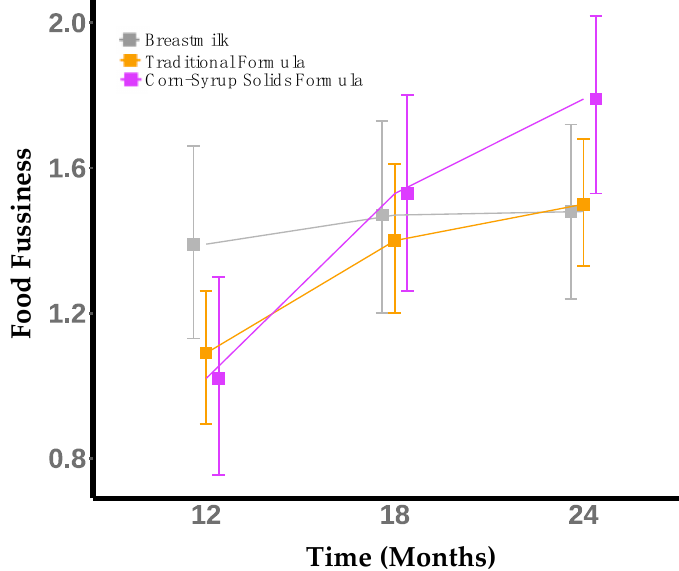
Figure 2. Food Fussiness increases from 12 to 18 months and 18 to 24 months for infants who con- sumed formula with added corn-syrup solids (CSSF) at 6 months. Food fussiness increases from 12 to 24 months for infants who consume traditional infant formula (TF) at 6 months. The model was adjusted for maternal pre-pregnancy BMI (kg/m 2 ), infant breast milk feedings per day and formula feedings per day, infant sex, infant birth weight (kg), mode of delivery, and socioeconomic status index (SES).